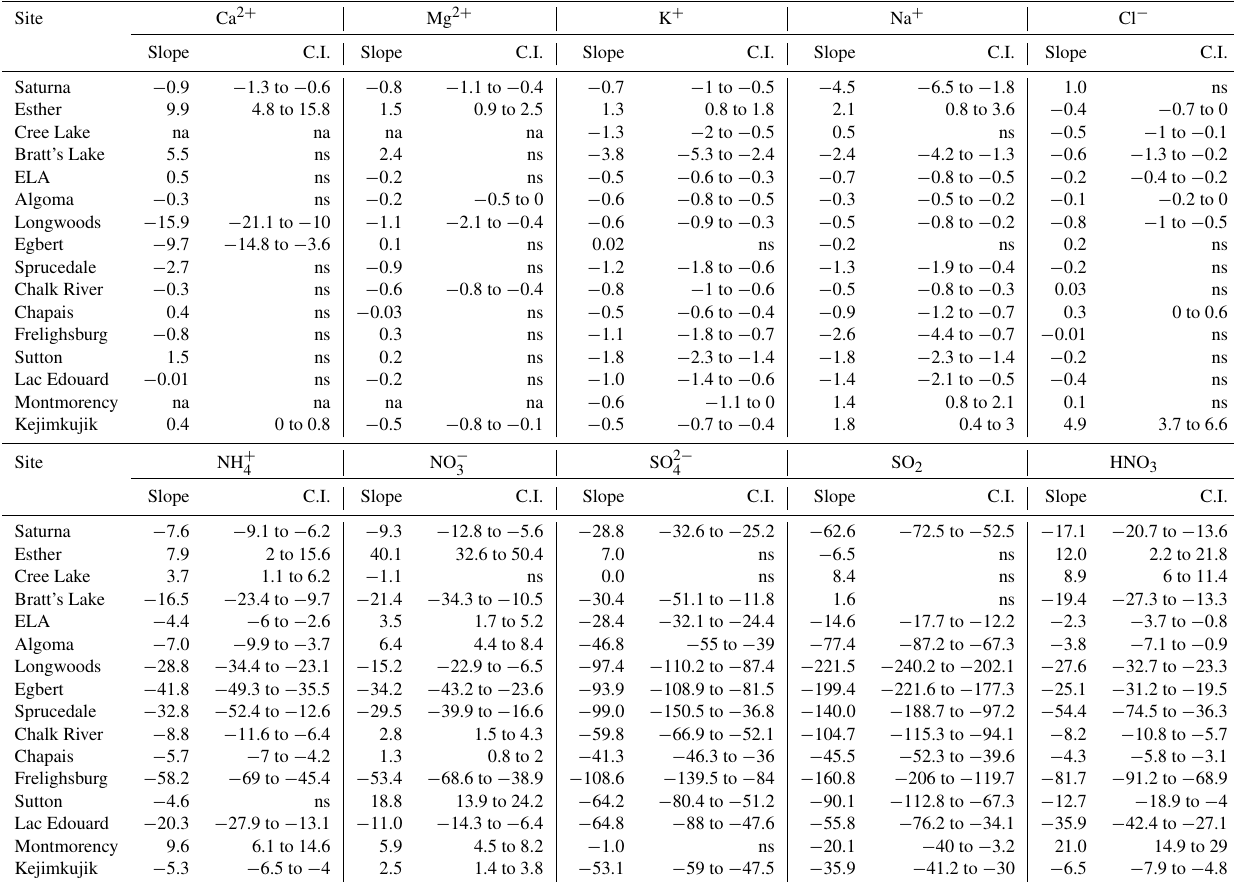
Table 2. Rate of change in annual air concentrations. Slope refers to the seasonal Kendall slope (ngm − 3 a − 1 ) ; C.I. refers to the 90% confidence interval of the slope; ns indicates no significant trend; na indicates no available data.